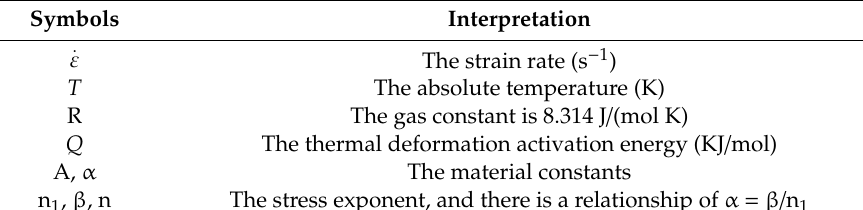
Table 3. The detail interpretation of the symbols in Equations (1)–(3).